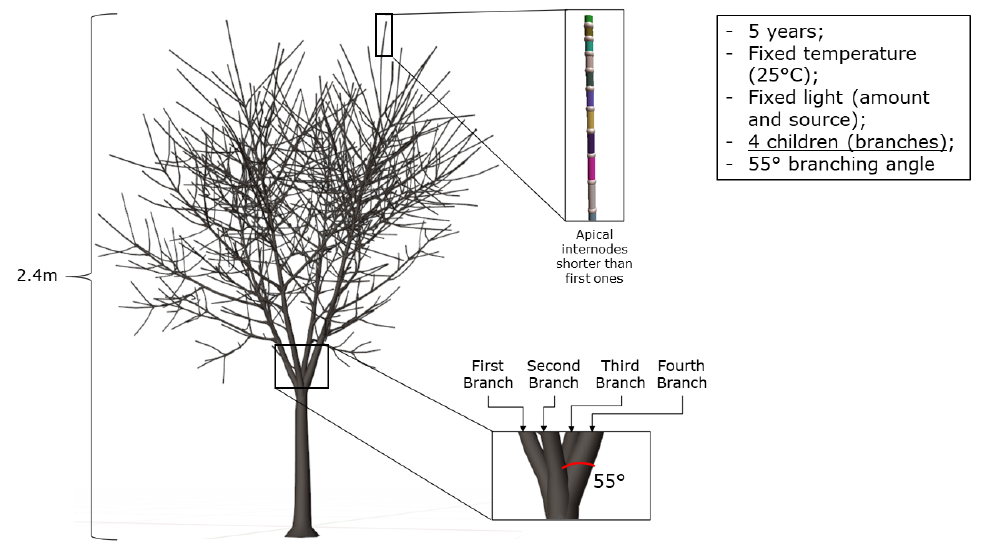
Figure 9. Tree growth with fixed temperature (25 °C), fixed light source (top) and amount, 55° branching angle and 4 children branches. The apical internodes are displayed with different colors for showing purpose.